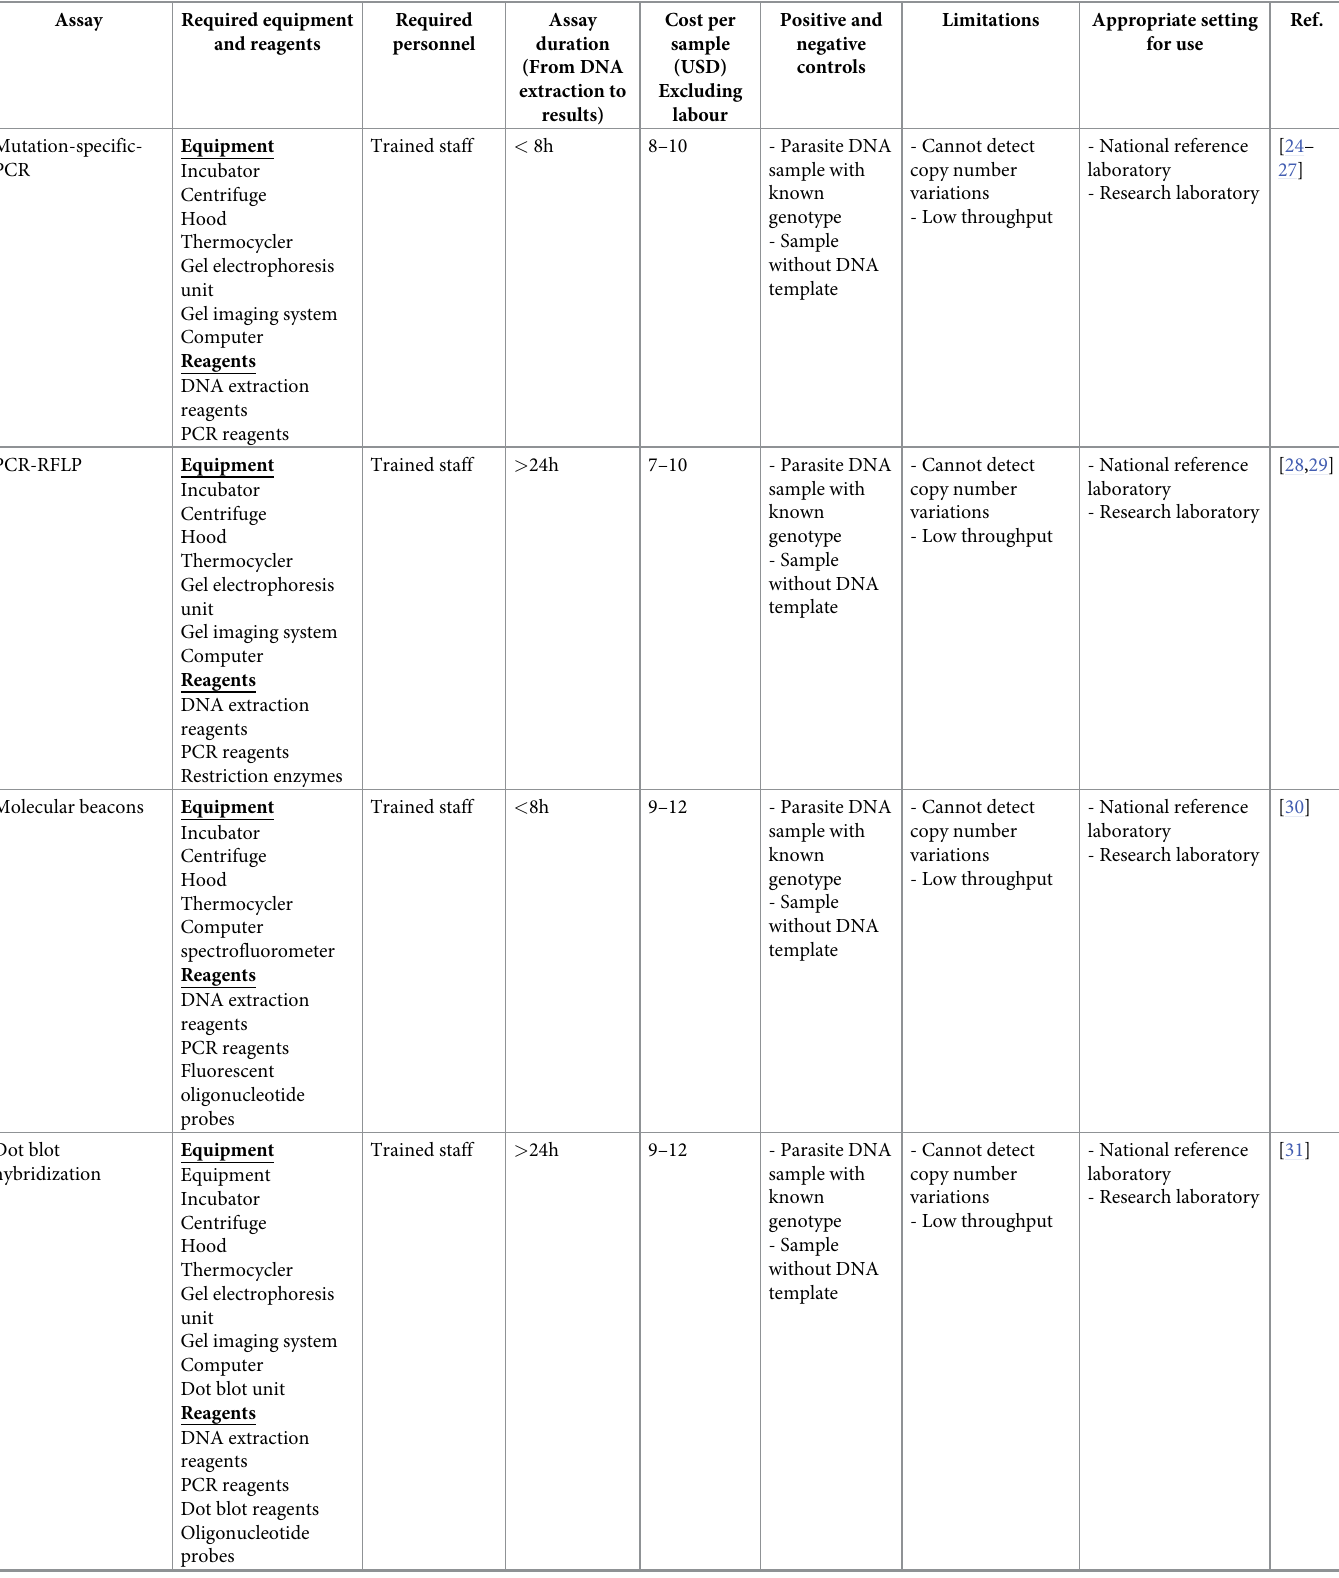
Table 1. Laboratory methods to assess molecular markers associated with antimalarial drug resistance.